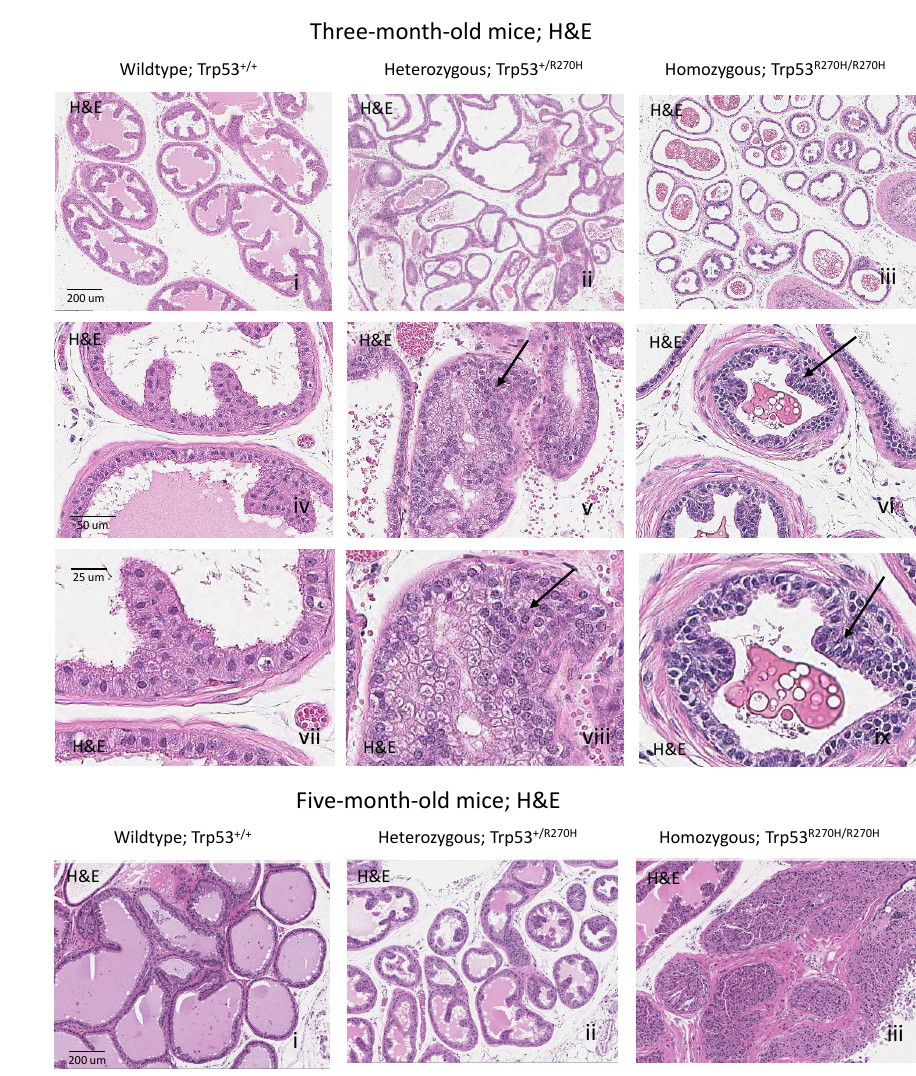
Figure 1. The Trp53 R270H mutant allele promotes the development of prostatic intraepithelial neoplasia (PIN). At ~3 months of age, areas of metaplasia and atypical hyperplasia (arrows) were observed in heterozygous mice ( Trp53 +/R270H ; A ii,v,viii) and grade 1 PIN lesions were observed in homozygous mice ( Trp53 R270H/R270H ; A iii,vi,ix) but not wildtype mice ( Trp53 +/+ ; A i,iv,vii). PIN lesions (arrows) were observed in older Trp53 +/R270H and Trp53 R270H/R270H ; mice (~5 months of age, B ii,iii, respectively). At ~5 months of age, grade 1 and grade 3–4 PIN lesions were observed in heterozygous and homozygous mice, respectively ( B i,ii). PIN lesions were not observed in Trp53 +/+ (wildtype) mice at either time point ( A i, B i). The combined data further confirm that the Trp53 R270H mutation can drive initiation of prostate carcinogenesis. Please note that a representative scale bar is included in the first image for each horizontal